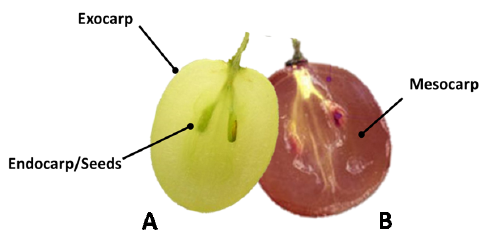
Figure 1. Similar structure of the white ( A ) and red ( B ) ripe grape berries (adapted from Rosa [54] and Agrisoil Research [55]).